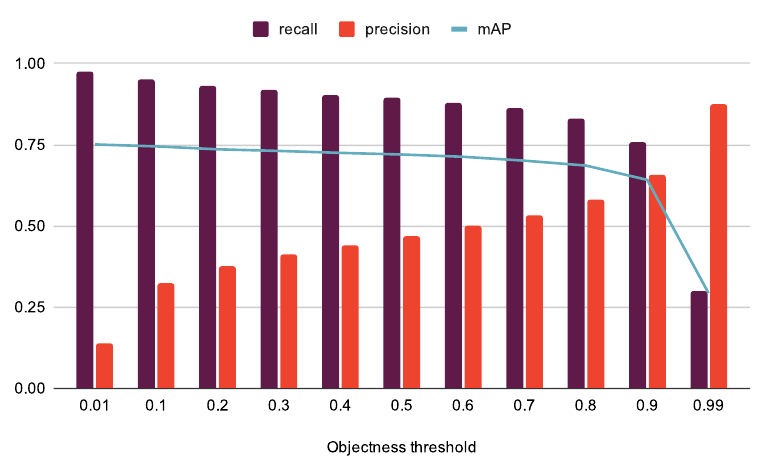
Figure 10. Objectness threshold influence on model performance (YOLOv3 trained with the ’divided’ dataset, results for validation subset).